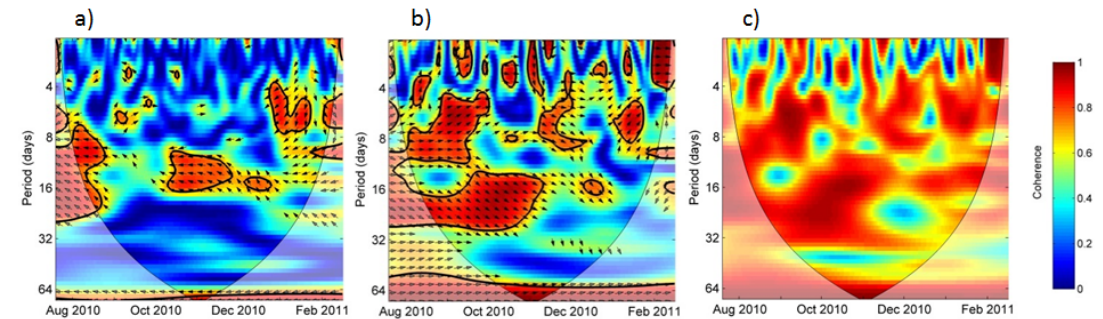
( a ; A tid ); the horizontal salinity gradient ( b ; Δ S ); and PC2 ( c ).